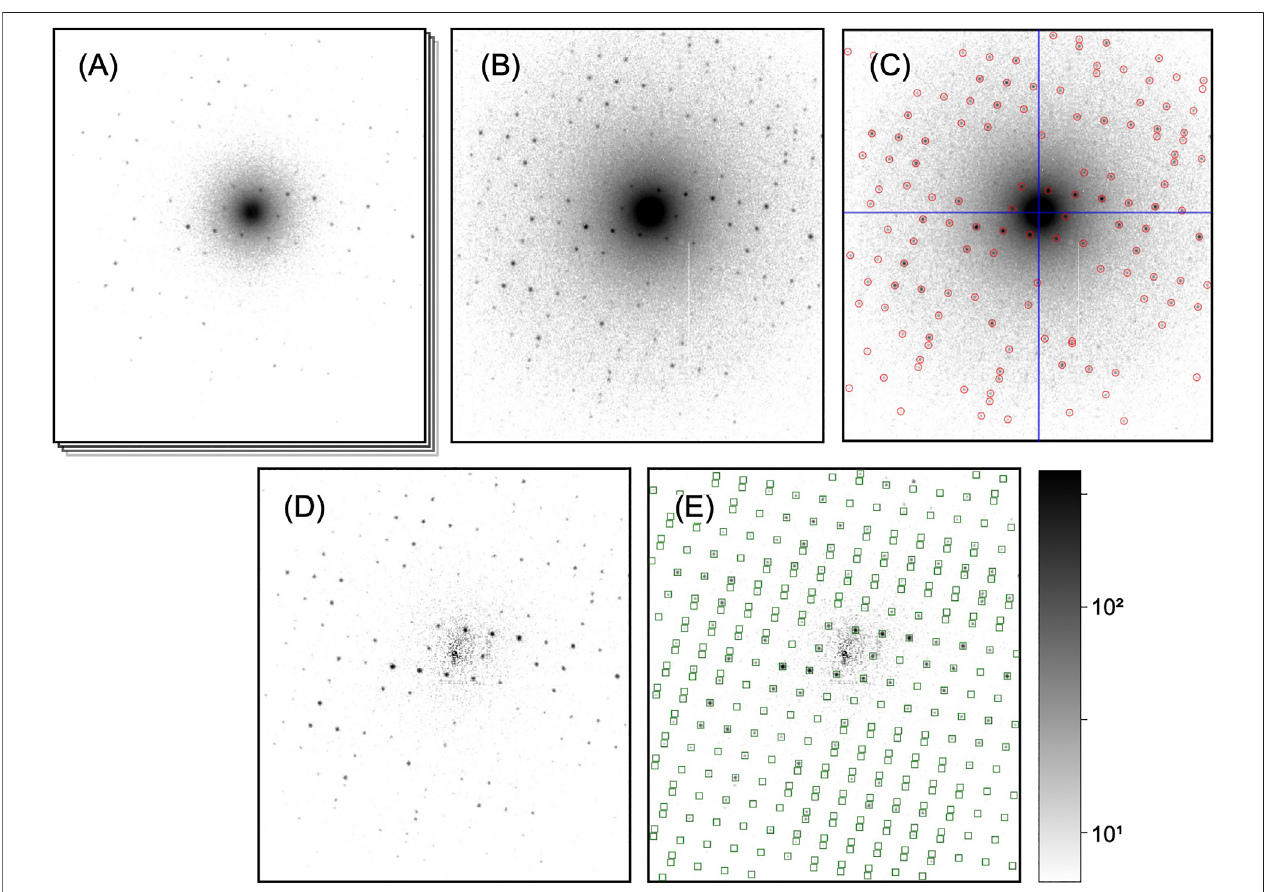
FIGURE3| Processingstepsofasinglediffractionpattern.Allpatternsareshownonthesame,logarithmicscale. (A) Initialdose-fractionationstack( fi rstfractionis shown). (B) Aggregated pattern over a range of four dose-fractionation frames (C) Pattern center (blue cross-hair) and Bragg peaks (red circles) have been determined. (D) Aggregated pattern after background subtraction (E) Predicted Bragg re fl ections (green squares) have been computed after successful indexing. In the integration step, those will be included as single